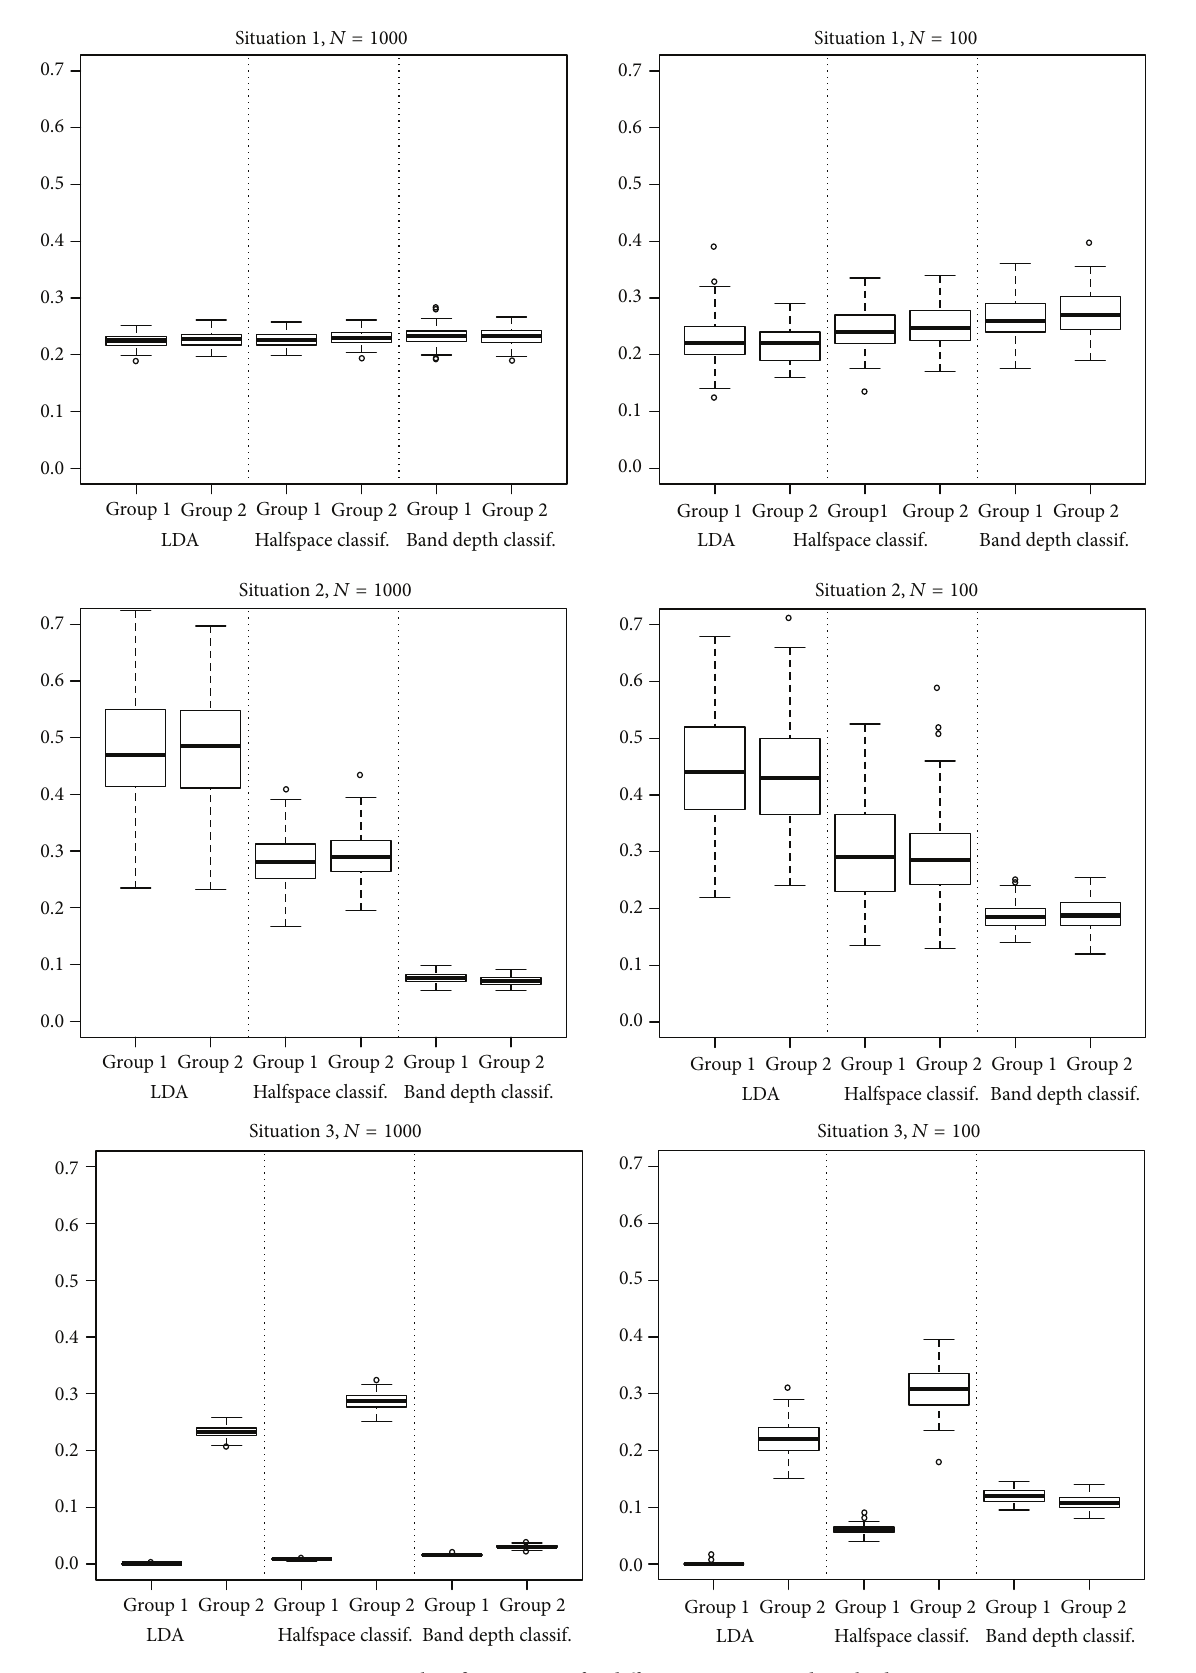
Figure 3: Misclassification rates for different situations and